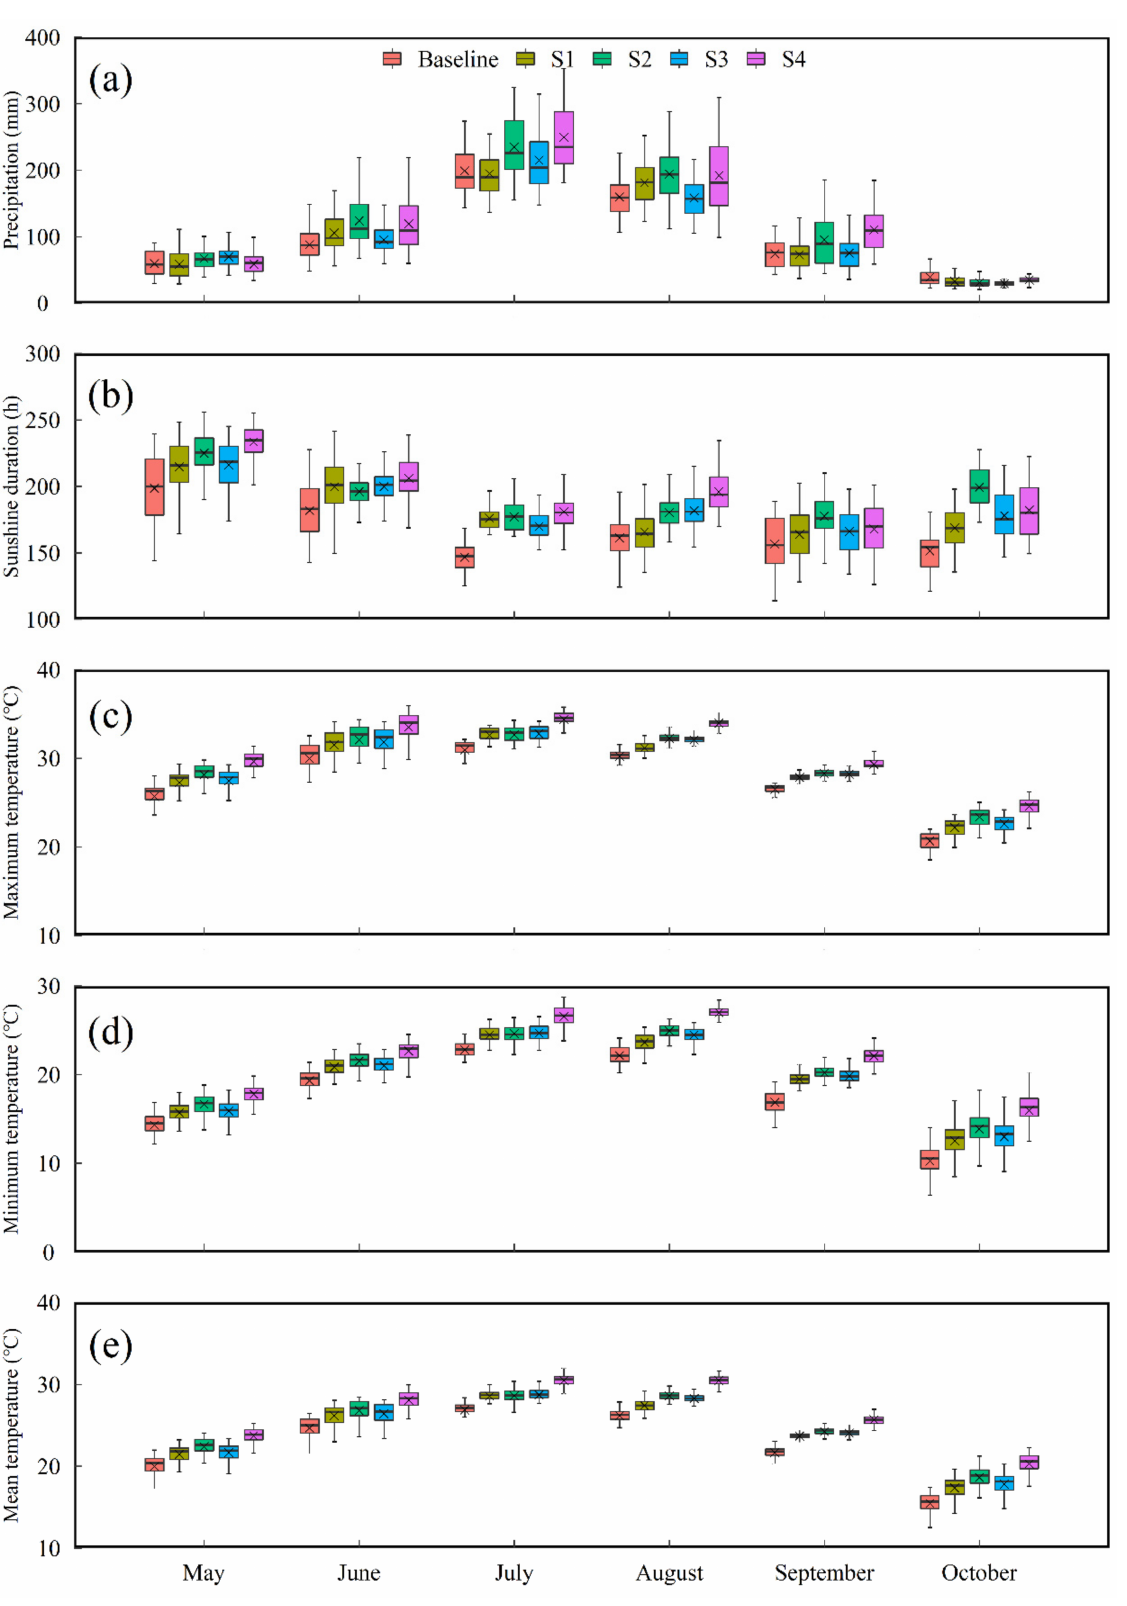
Figure 9. The temporal change of precipitation ( a ), sunshine duration ( b ), maximum temperature ( c ), minimum temperature( d ) and, mean temperature ( e ) from May to October in the North China Plain during the baseline period, the 2040s and